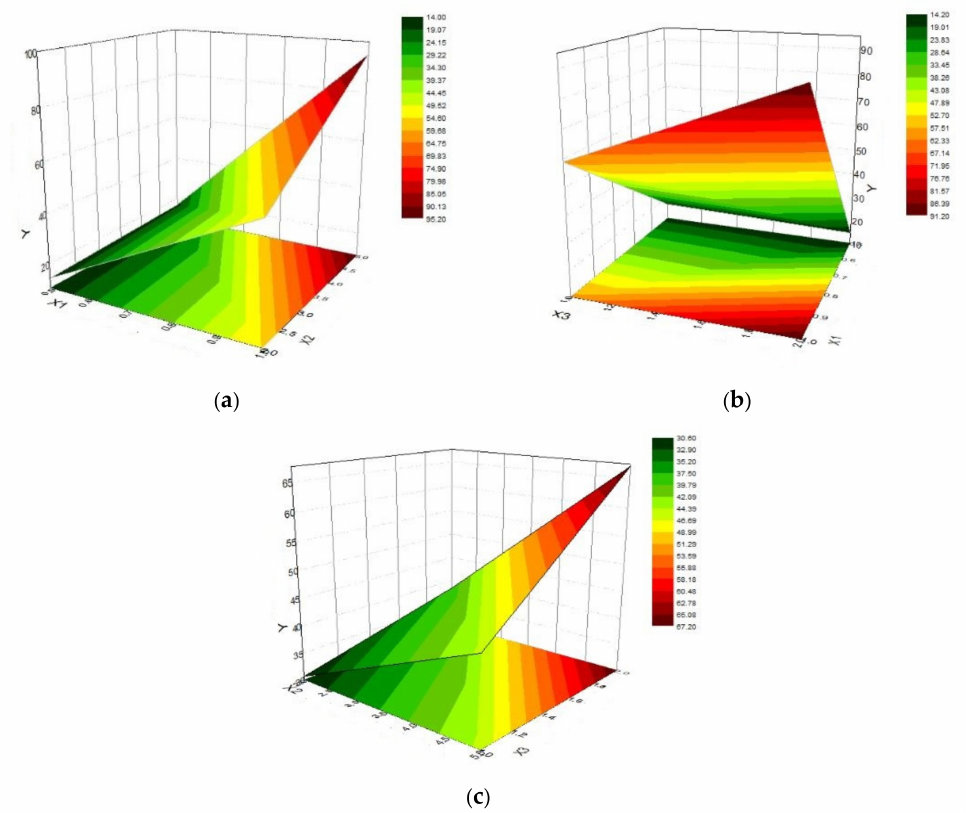
Figure 9. Highlighting in 3D the evolution of the Y (viscosity) parameter according to the formulation variables ( a ) X 1 (chitosan concentration) and X 2 (HPMC E 5 LV concentration); ( b ) X 1 (chitosan concentration) and X 3 (chitosan/HPMC E 5 LV ratio); and ( c ) X 2 (HPMC E 5 LV concentration) and X 3 (chitosan/HPMC E 5 LV